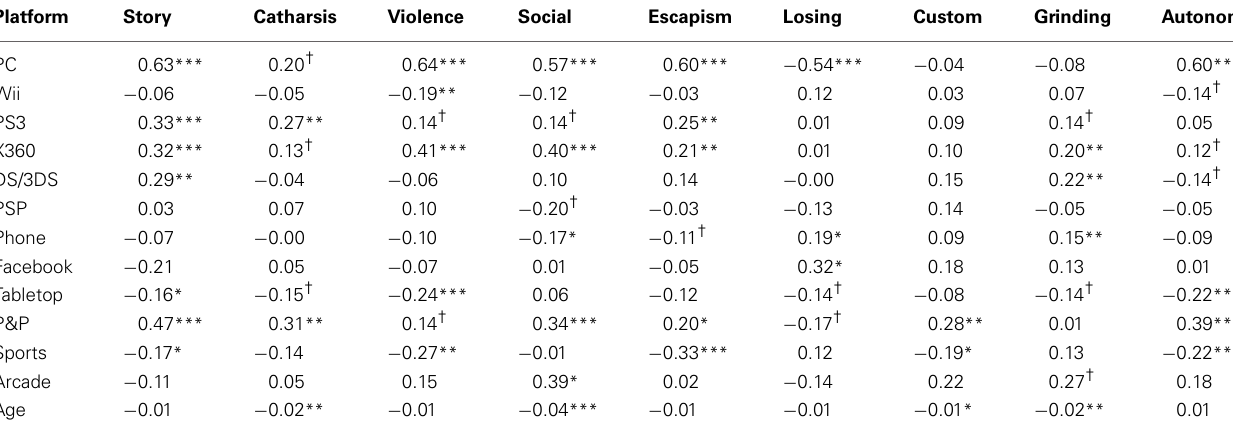
Table 6 | Coefficients of game platform effects on GAMES